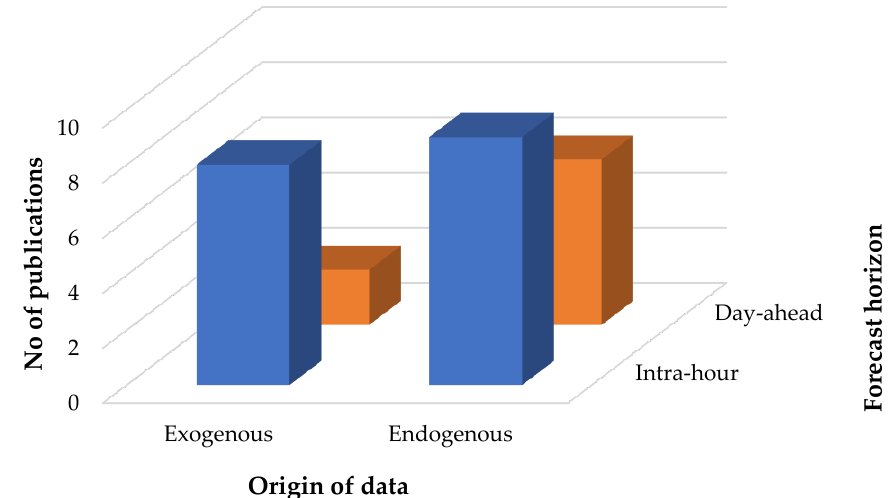
Figure 11. The number of publications based on the origin of data and forecast horizon.